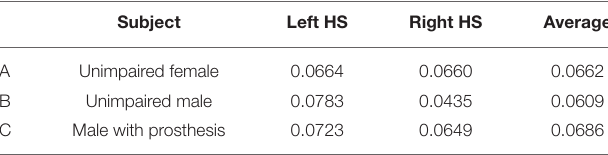
TABLE 2 | Normalized residual orbital energy E ′ res [1 / s 2 ] at left and right hell strike (HS) and the average